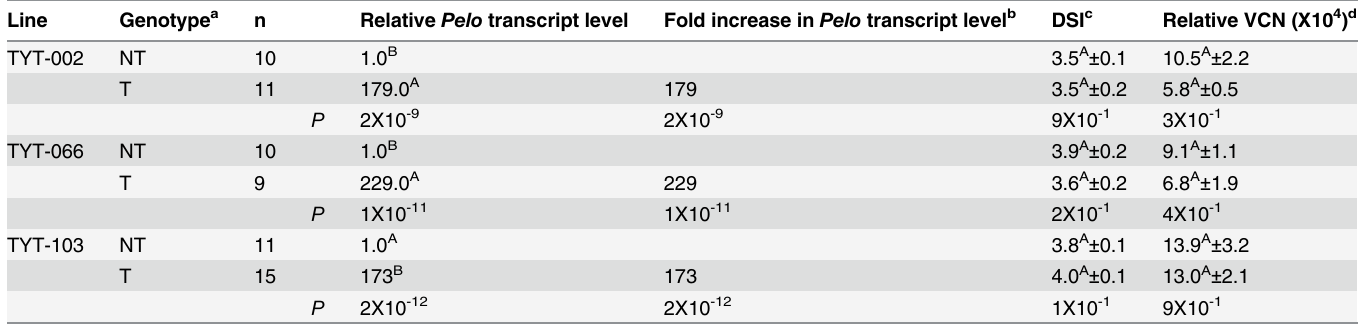
(Table 4). Following inoculation with TYLCV, all the transgenic plants showed no disease Table 3. Effect of over-expressing the Pelo allele derived from TY172 plants in transgenic R13 plants. Line Genotype